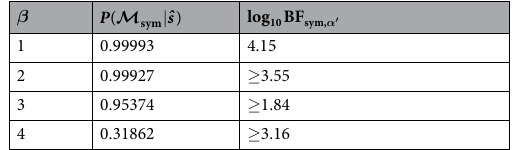
Table 1. Posterior  | ˆ P s ( )